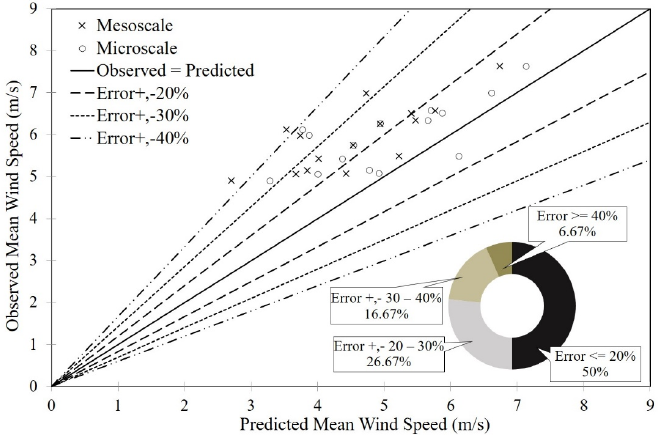
Figure 8. Scatter plot of the predicted and WRF mean annual wind speeds at 120 m agl for 15 representative locations within the study area.